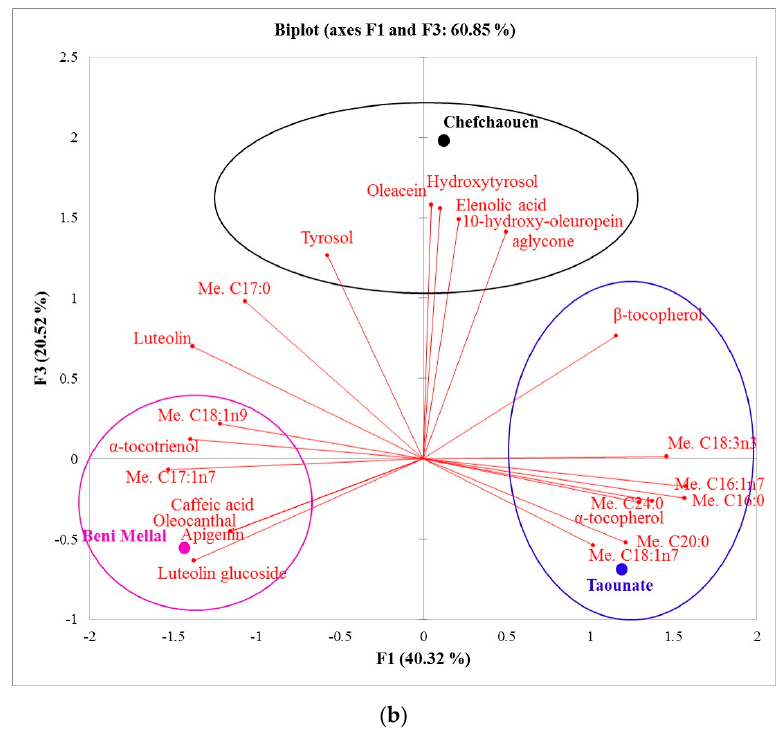
Figure 3. Principal component analysis (PCA) between phenolic compounds, vitamin E and fatty acids in VOO of Picholine marocaine and five provinces studied. ( a ) The first and second discriminant function; ( b ) the first and third discriminant function.